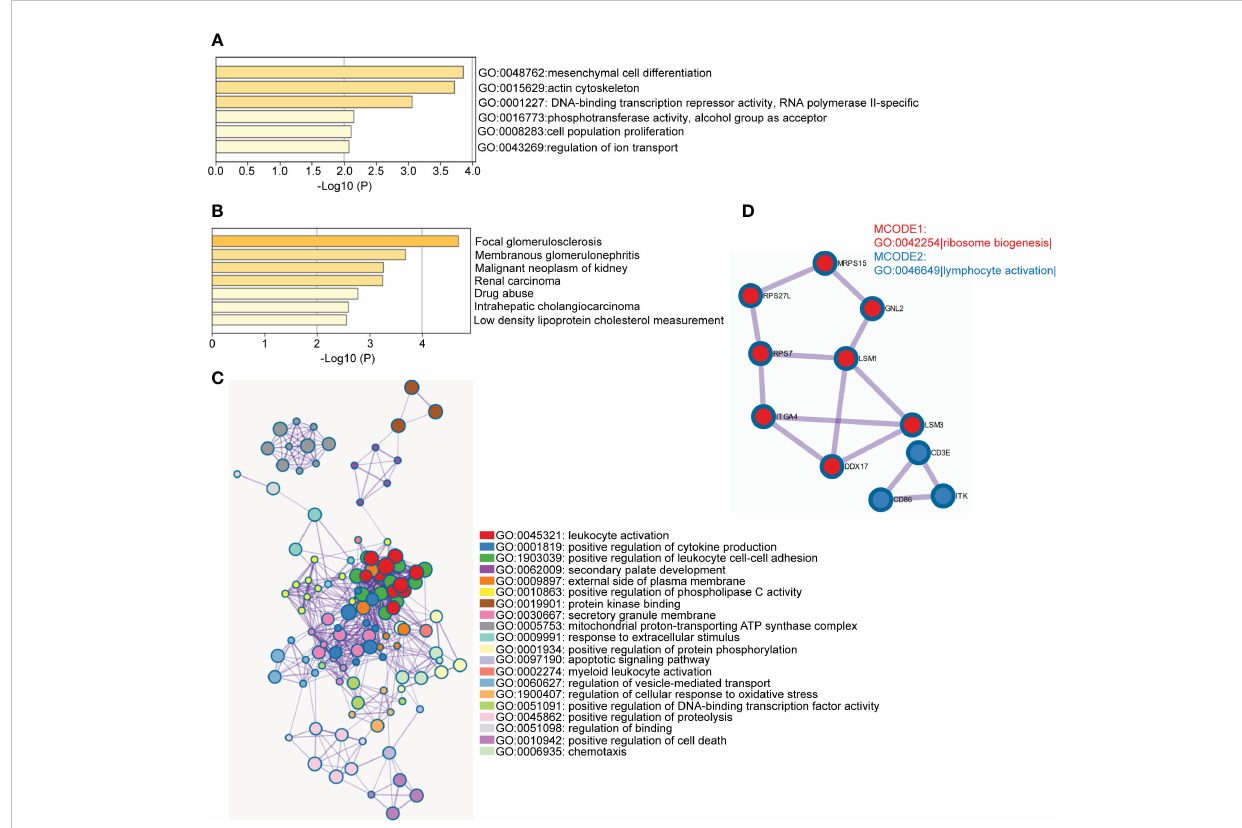
FIGURE 5 Functional enrichment analysis of hub genes in disease-related module (A) Enriched GO terms among TISSUE hub genes. The horizontal axis represented P-value of GO terms in log10 calculated on Metascape by default parameter. (B) Enriched DisGeNET terms among TISSUE hub genes. The horizontal axis represented P-value of GO terms in log10 calculated on Metascape. (C) Network of representative GO terms among PBMC hub genes. The clusters were calculated and visualized with Cytoscape using Metascape online platform by default parameter. The color of the node represented its cluster identity. One GO term from each cluster was selected to be shown as label. (D) Top MCODE terms of PBMC hub genes. All PPI among PBMC hub genes formed a network. The Molecular Complex Detection algorithm (MCODE) was used to identify the connected network components. The network was analyzed by GO enrichment to extract “ biological meanings ” . One GO term was labelled to represent the MCODE (GO: 0042254: Ribosome biogenesis; GO: 0046649: lymphocyte